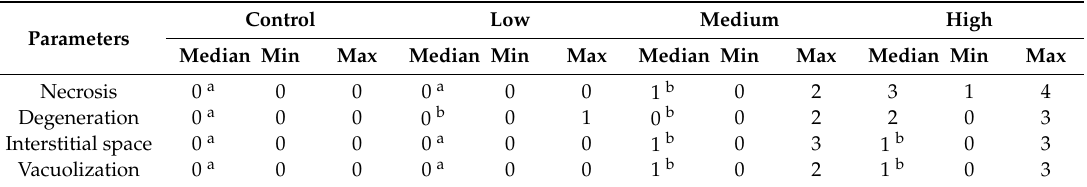
Control, Low, Medium and High represent 0, 2, 4 and 6 mg lovastatin / kg BW, respectively. Data was presented as the median, minimum and maximum of the score. a,b Score within a row with di ff erent superscripts di ff er significantly at p <